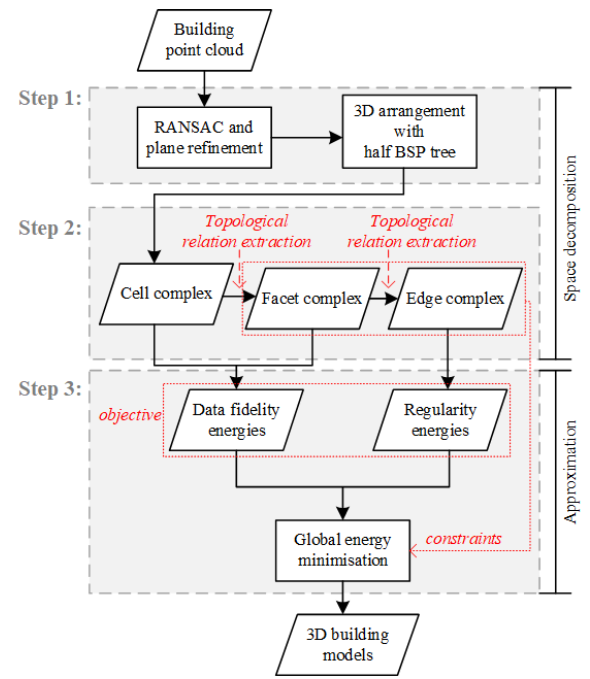
Figure 1. Overview of the proposed